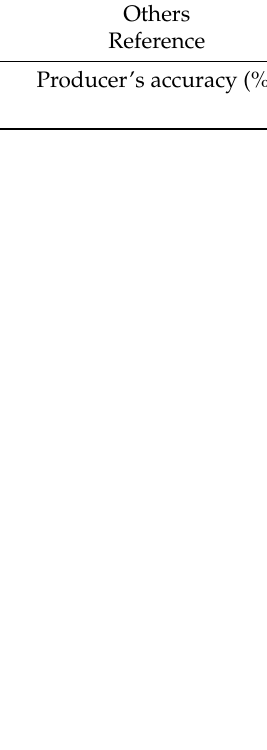
Table 5. Confusion matrix of Duan’s method in typical sites [42].